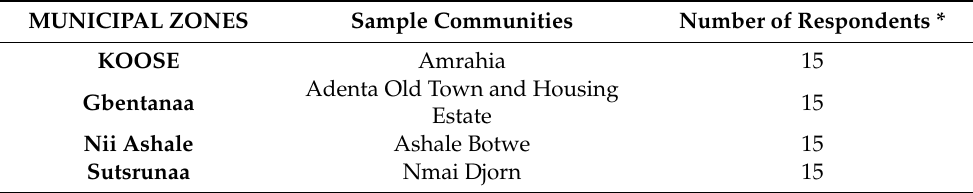
Table 1. Details on respondents and